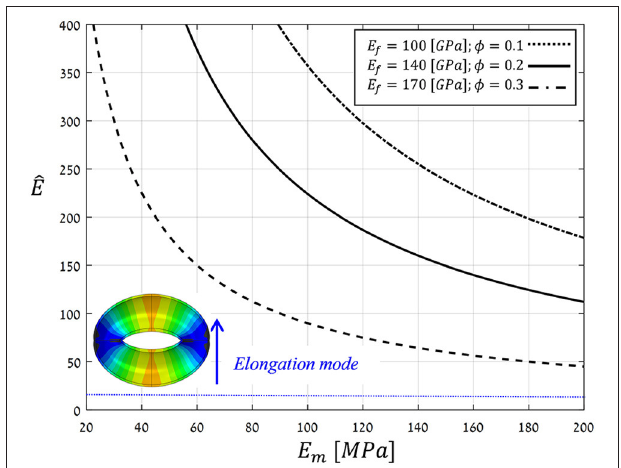
FIGURE 10 | Theoretical estimations for the anisotropy parameter ˆ E calculated by Voigt and Ruess using composite models for a range of typical Young’s moduli of cellulose microfibril, hemicellulose matrix, and microfibril contents in living plant tissues, i.e., wet conditions ( E f , E m and φ , respectively) (Salmén, 2004; Gibson et al., 2010; Cintrón et al., 2011; Dri et al., 2013). The threshold ˆ E * 10, above which guard cell deformation is in elongation = mode, is indicated by the blue line; inset shows a representative opening displacement field in elongation mode (for ˆ E 40 > ˆ E * =